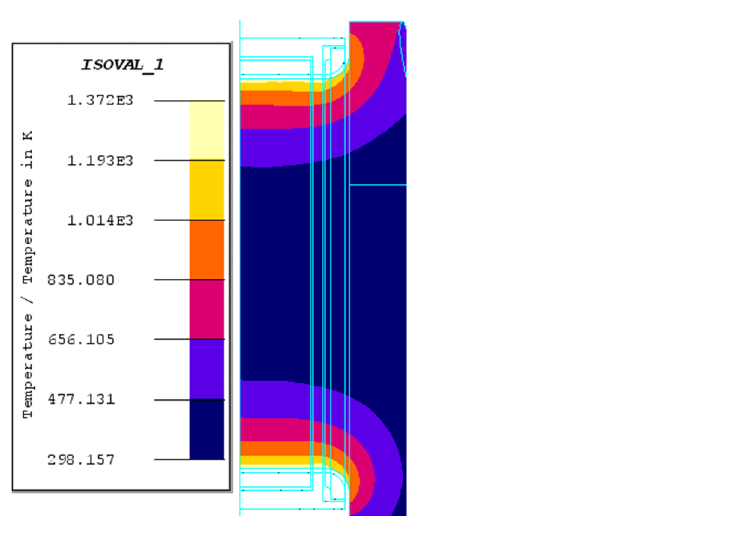
Figure 4. Temperature field of crankshaft N0 during the heating stage (T = 5S).